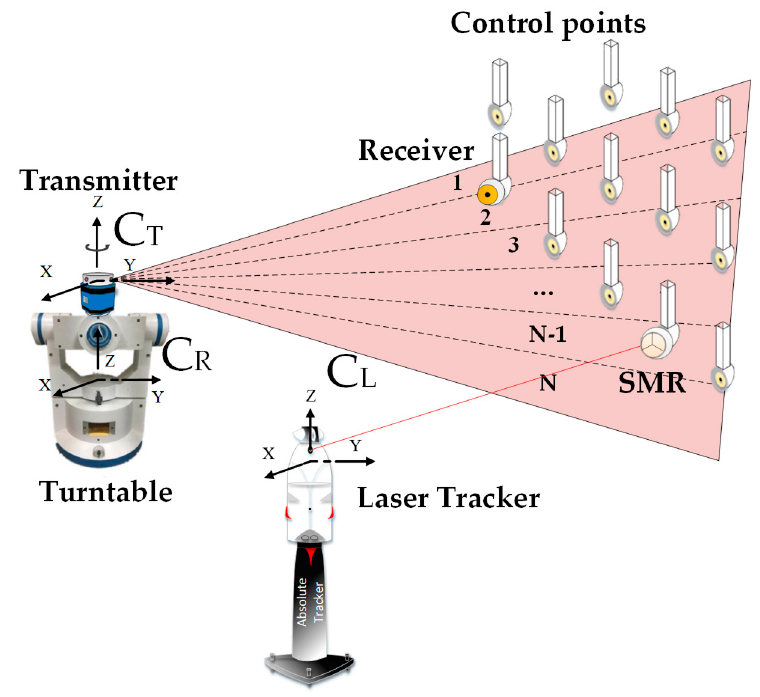
Figure 1. The schematic of the sub-regional